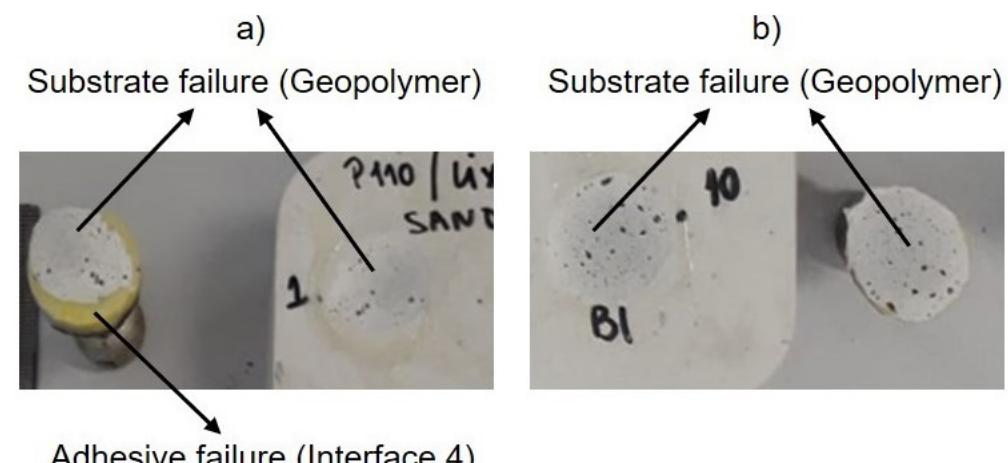
Figure 8. Fracture surfaces of specimens with (a) combined substrate and adhesive failure and (b) pure substrate failure.